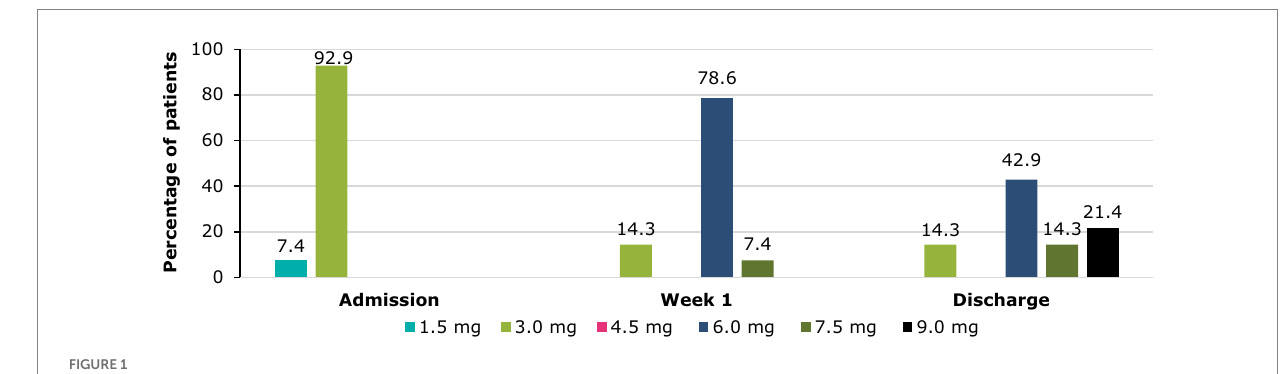
FIGURE 1 Cariprazine doses between admission and